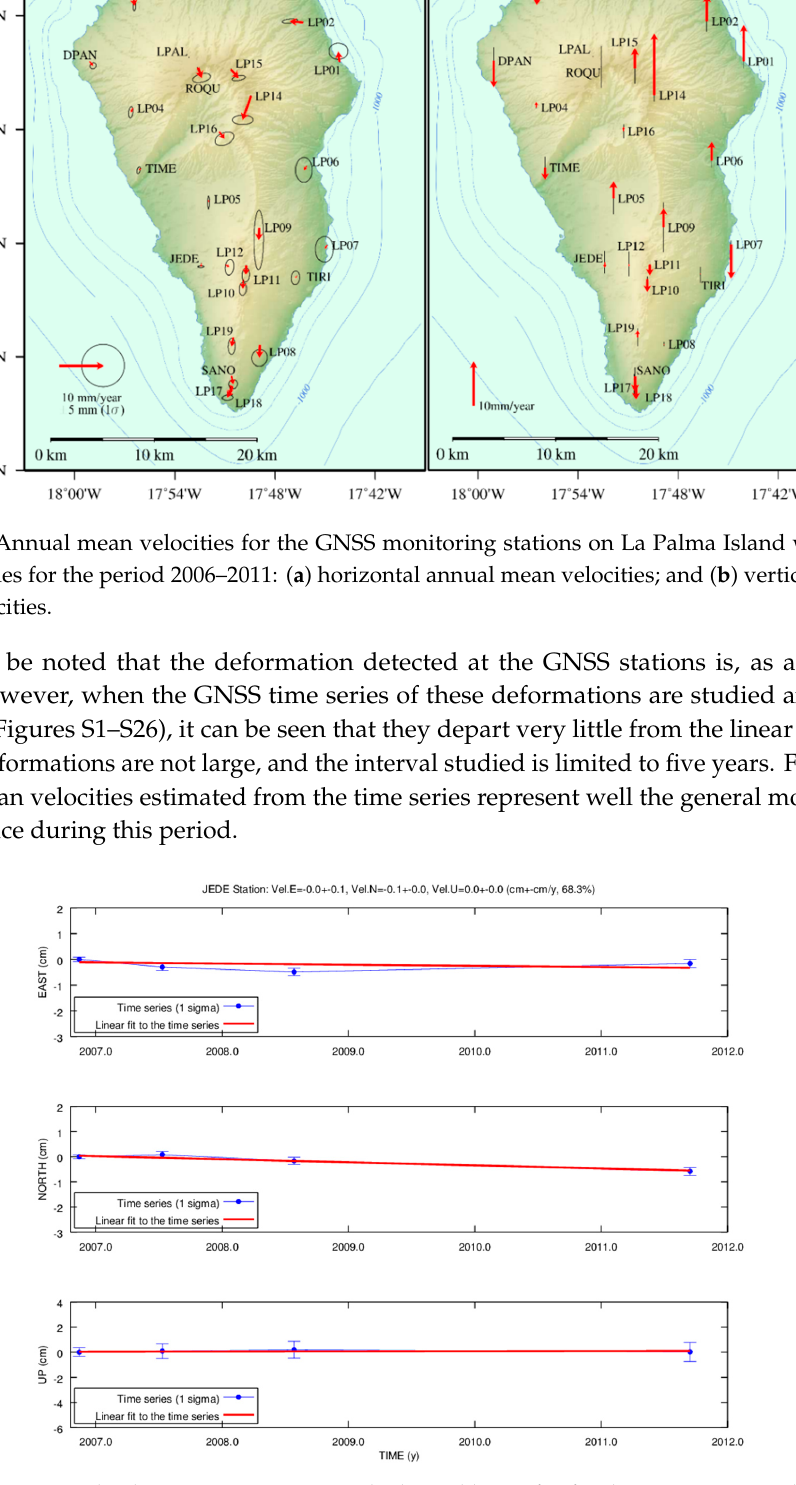
Figure 4. 3D GNSS displacement time series and adjusted linear fits for the JEDE station. This station was used as one of the velocity seeds with zero cm/year (in LOS projection) for A-DInSAR processing of descending orbit images. The red lines on the subfigures show the linear fit to the time series used to estimate the mean annual velocities.